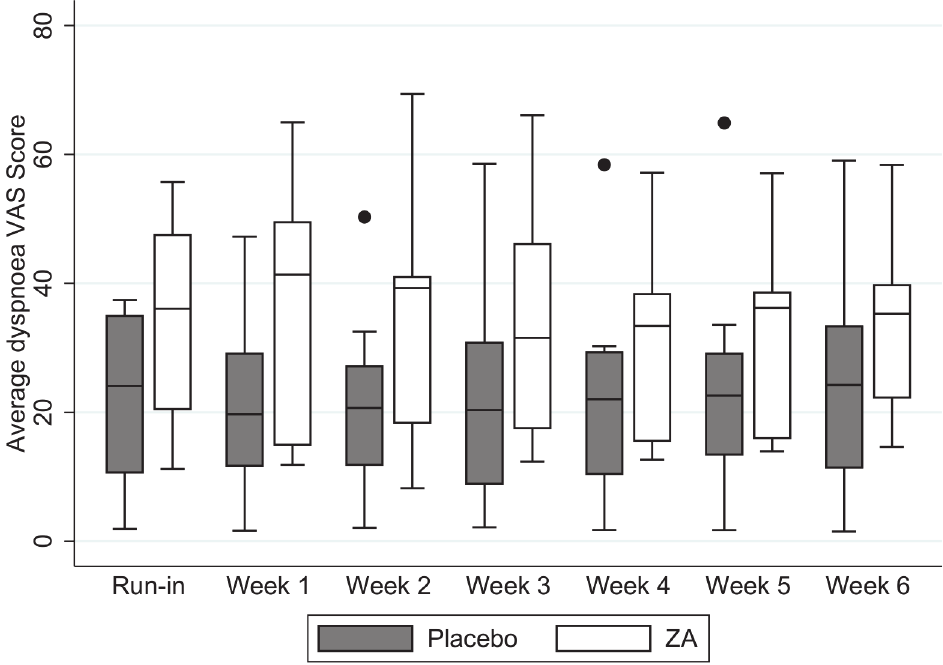
Fig 2. Box and whisper plot evaluating the average weekly VAS breathlessness scores for the 2 treatment arms. The horizontal line with the box represents the median. The box edges represent the lower (25 th ) and upper (75 th ) quartiles. The whiskers represent the lower and upper adjacent values. Outside values are plotted separately.